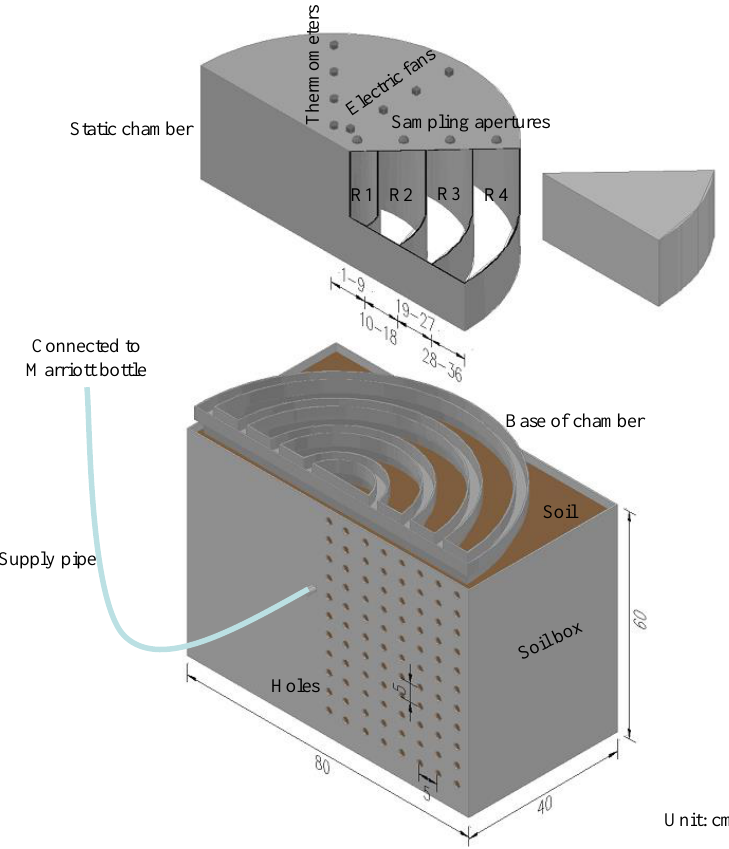
Figure 1. Diagram of sub-surface drip irrigation (SDI) box and the static chamber.